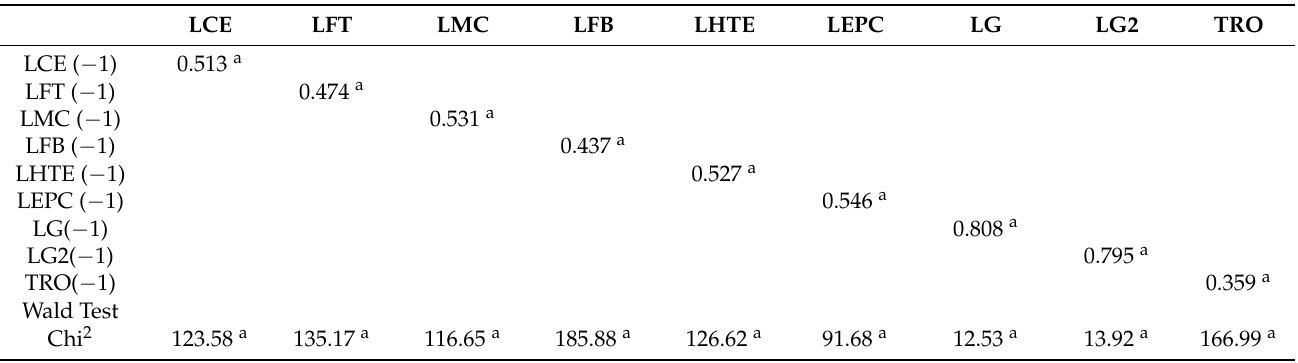
Table 4. Unit root